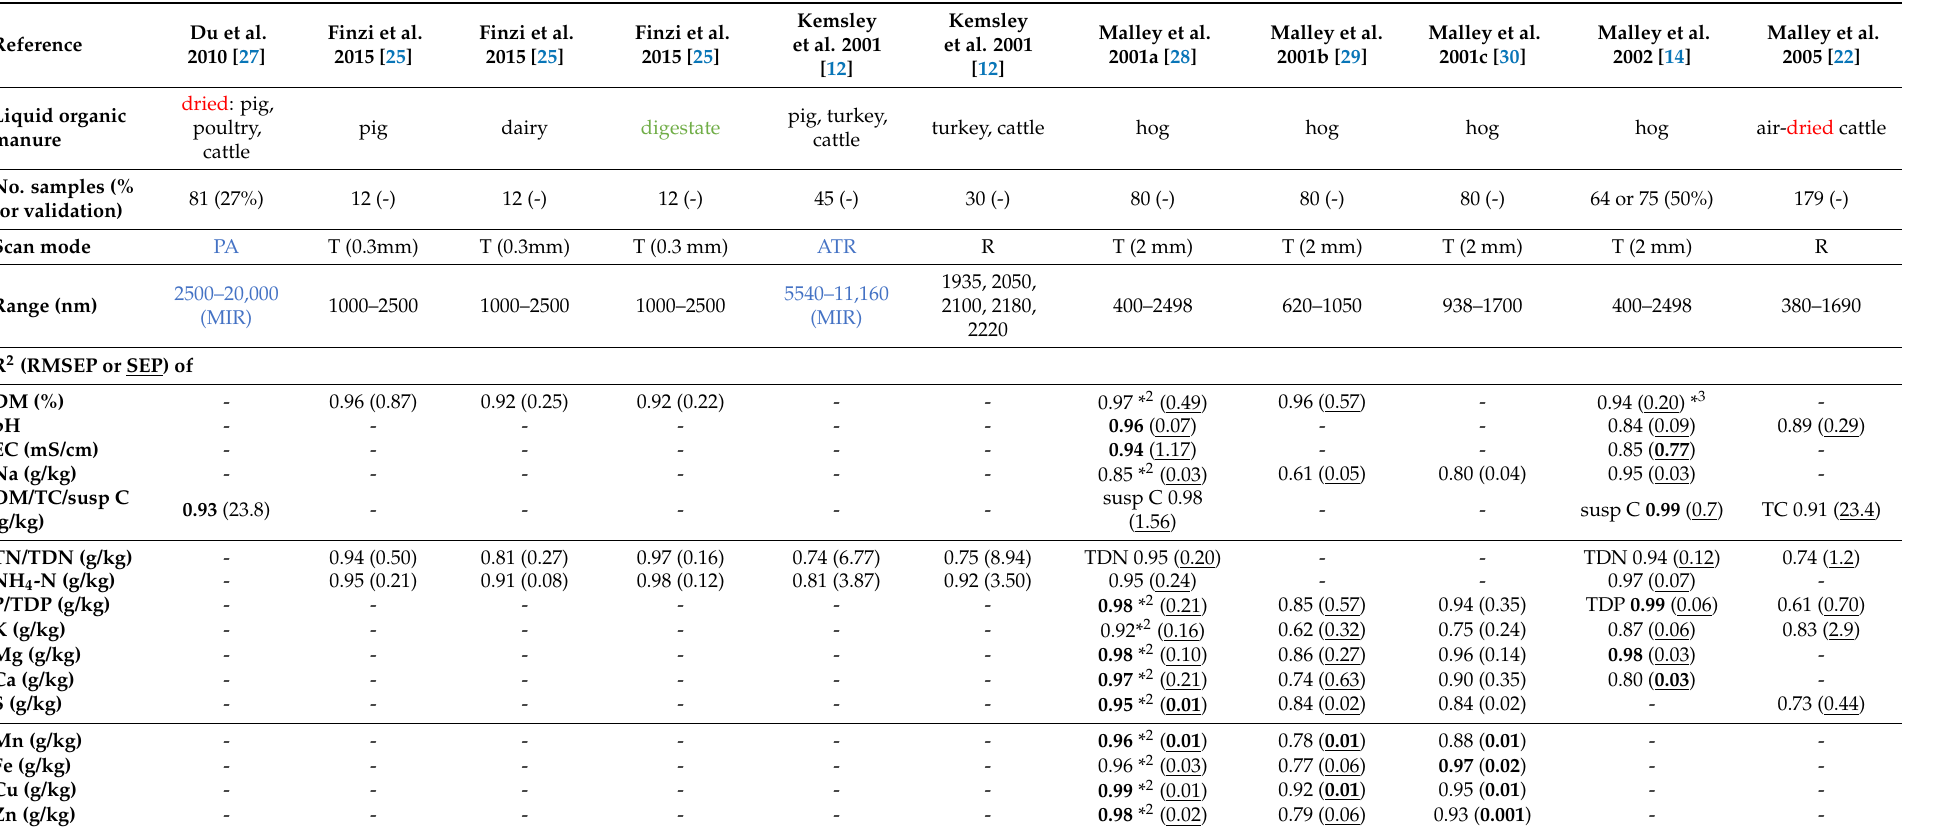
Best values for each parameter are highlighted in bold letters, dried samples in red, digestate samples in green, MIR technique in blue, and SEP values in underlined letters. Scan mode: R = reflectance, T = transflectance, ATR = attenuated total reflection, PA = photoacoustic; Parameters: DM = dry matter, EC = electrical conductivity, OM = organic matter, TC = total carbon, susp C = suspended carbon, TN= total nitrogen, TDN = total dissolved nitrogen, TP = total phosphorus, TDP= total dissolved phosphorus; R 2 = coefficient of determination, RMSEP = root mean squared error of prediction, SEP = standard error of prediction. * 2 Not published in Malley et al. (2001a) [28], but later in Malley et al. (2001c) [30]. * 3 DM calculated from parameter moisture (m) by DM = 1 −